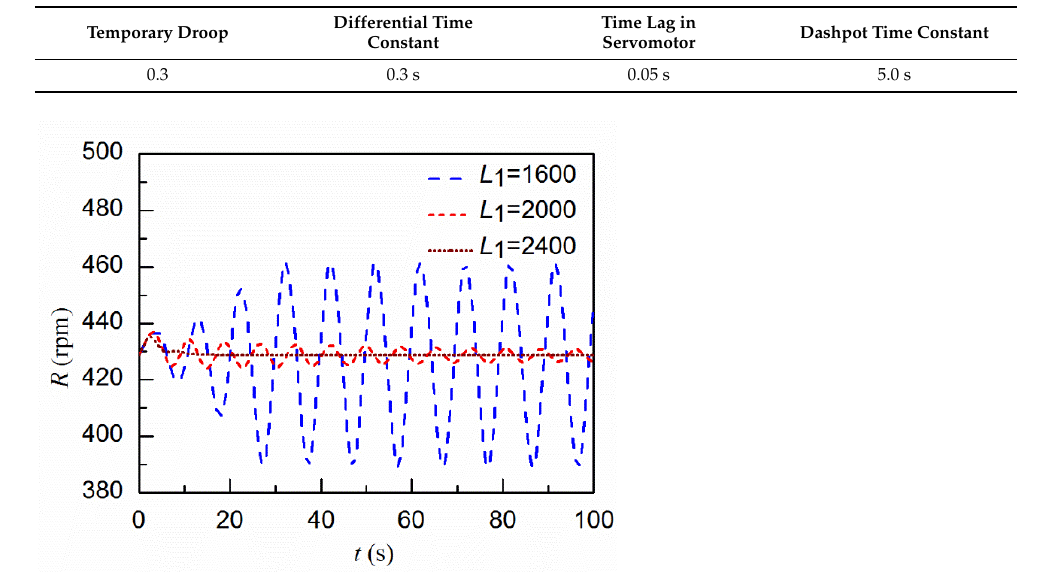
Table 2. Parameter setting for the PID controller. Table 2. parameter setting for the PID controller.